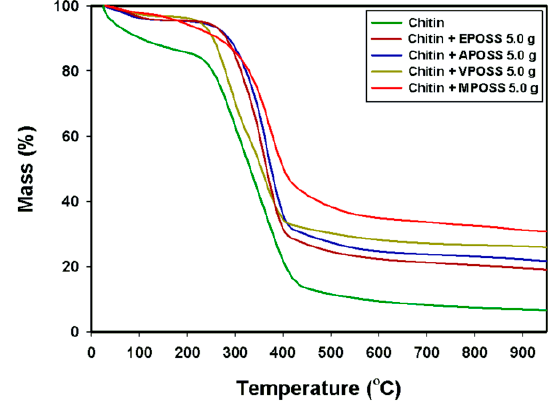
Figure 3. Thermogravimetric (TG) curves for α -chitin and for the products obtained by functionalization with various POSS